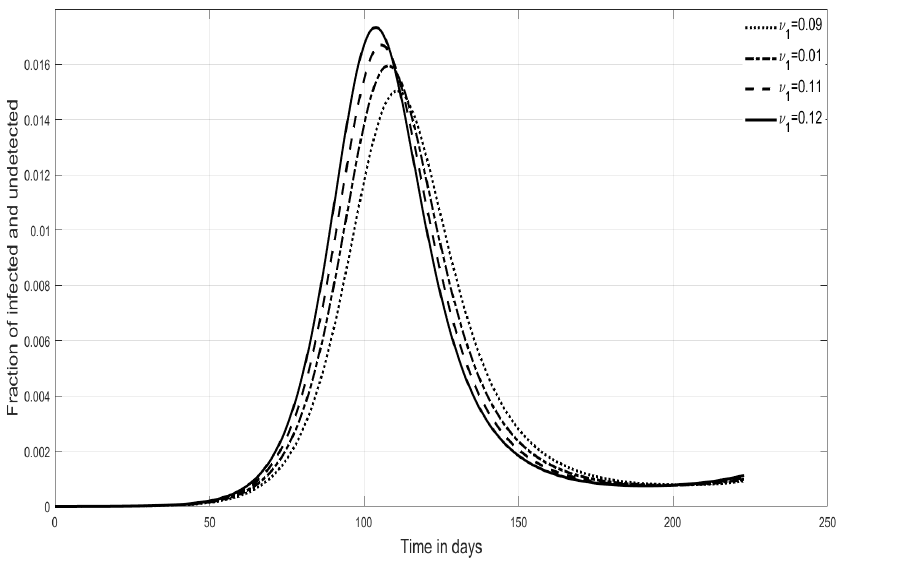
Figure 4. Shows the effects of varying ν 1 of the fraction of undetected